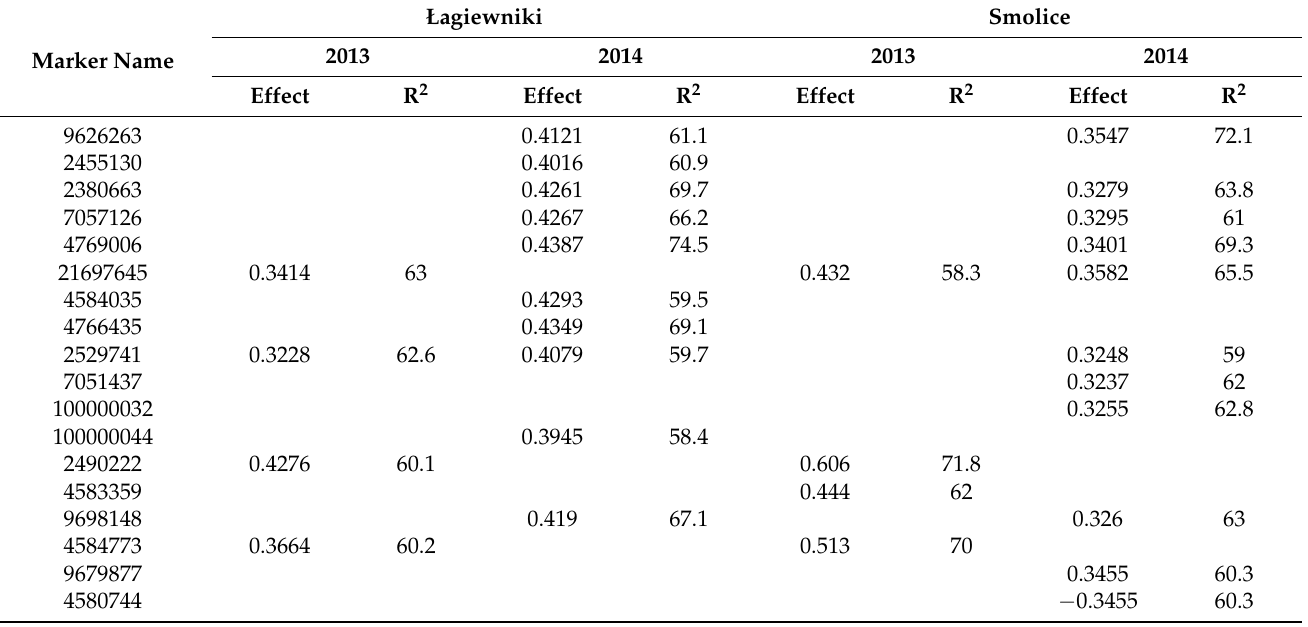
Table 2. Molecular markers (SilicoDArT) significantly (LOD > 3.0) associated with the heterosis effect of cob diameter